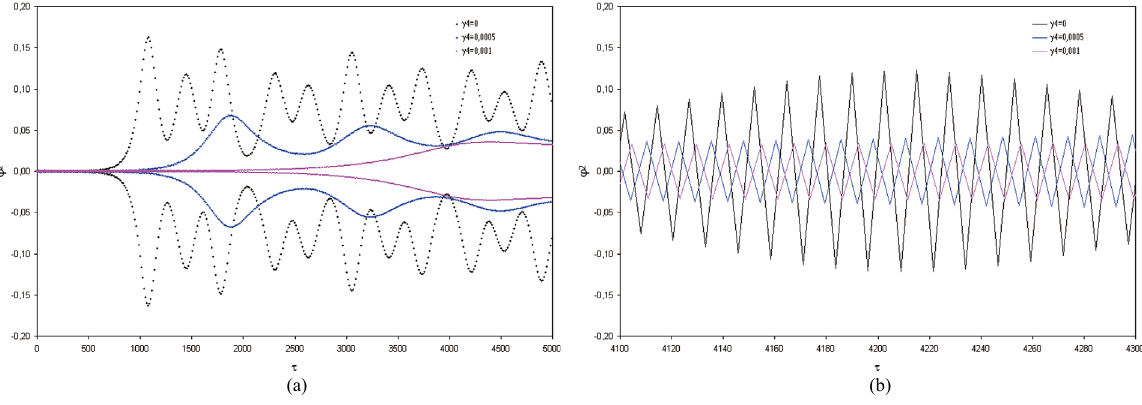
Fig. 4. Numerical solutions of ϕ 2 for different coefficients γ 4 and for a 1 = a 2 = 0.1; a 3 = 0.0001; γ 1 = 0.0001; γ 2 = γ 3 = 0; β 1 = 0.65; c = 1; u 1 = u 2 = 1.5; q = 0.1: (a) envelopes of displacements ϕ 2 , (b) time history of ϕ 2 for the region τ ∈